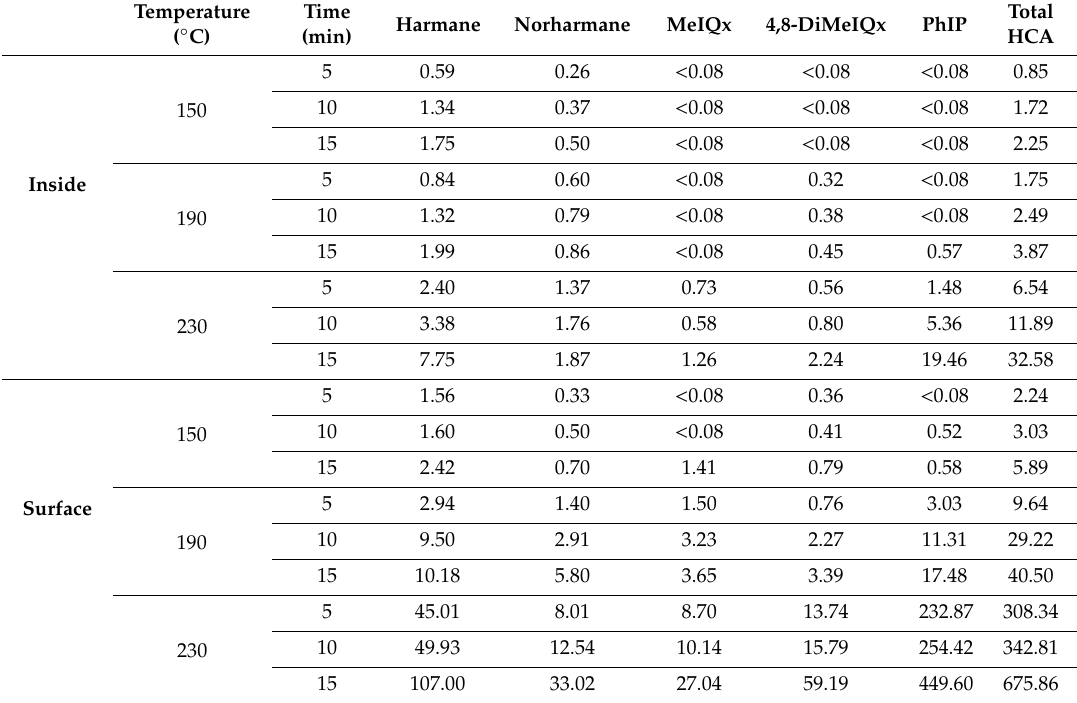
Closed / Opened: the position of the top plate of the contact grill. Table 2. Heterocyclic amine content of samples without skin, grilled closed (ng / g). Temperature ( ◦